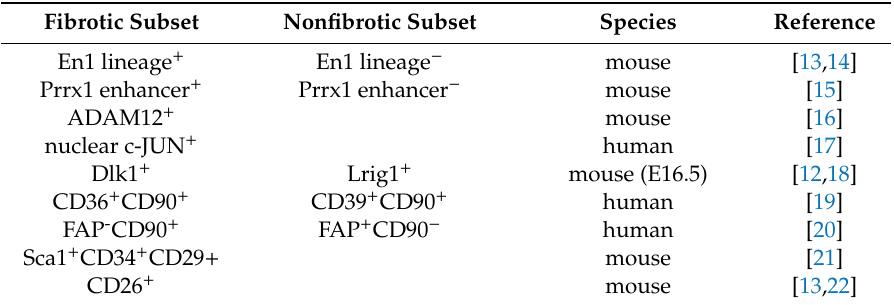
Table 1. Dermal fibroblast subsets with intrinsic fibrotic